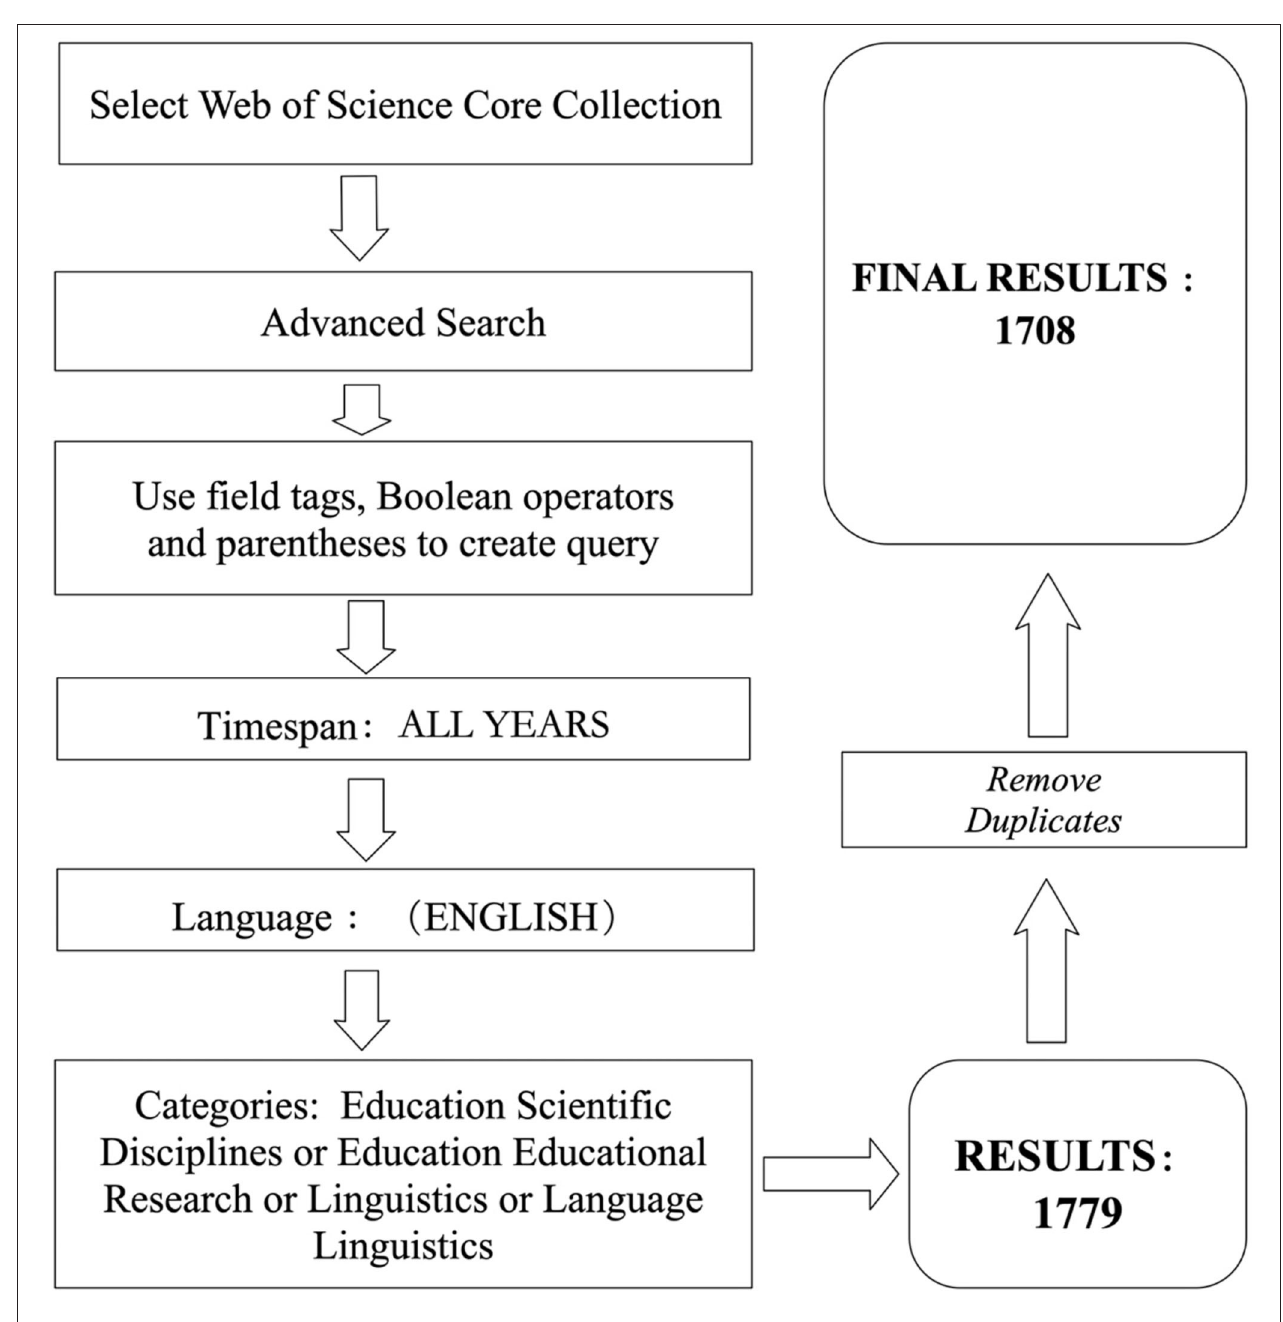
FIGURE 1 | Stages of data